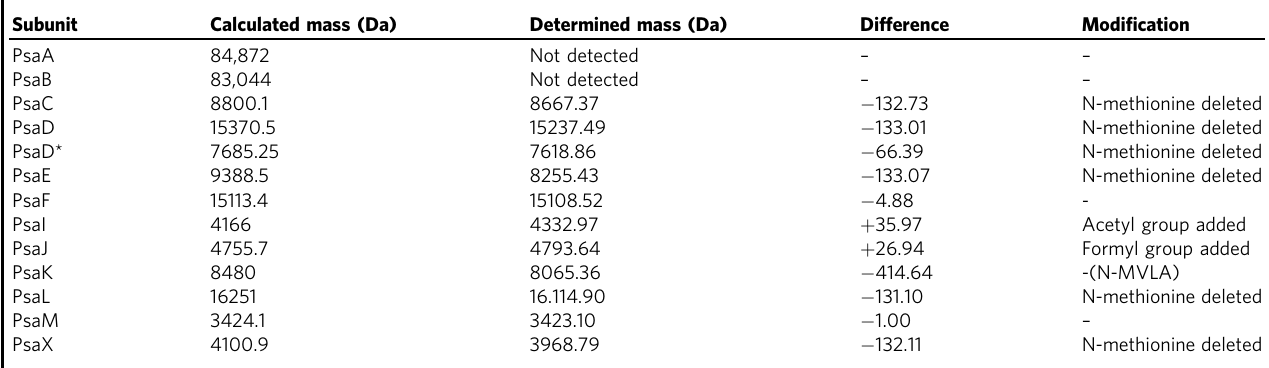
Table 1 Calculated and determined masses of PSI subunits from T. elongatus .